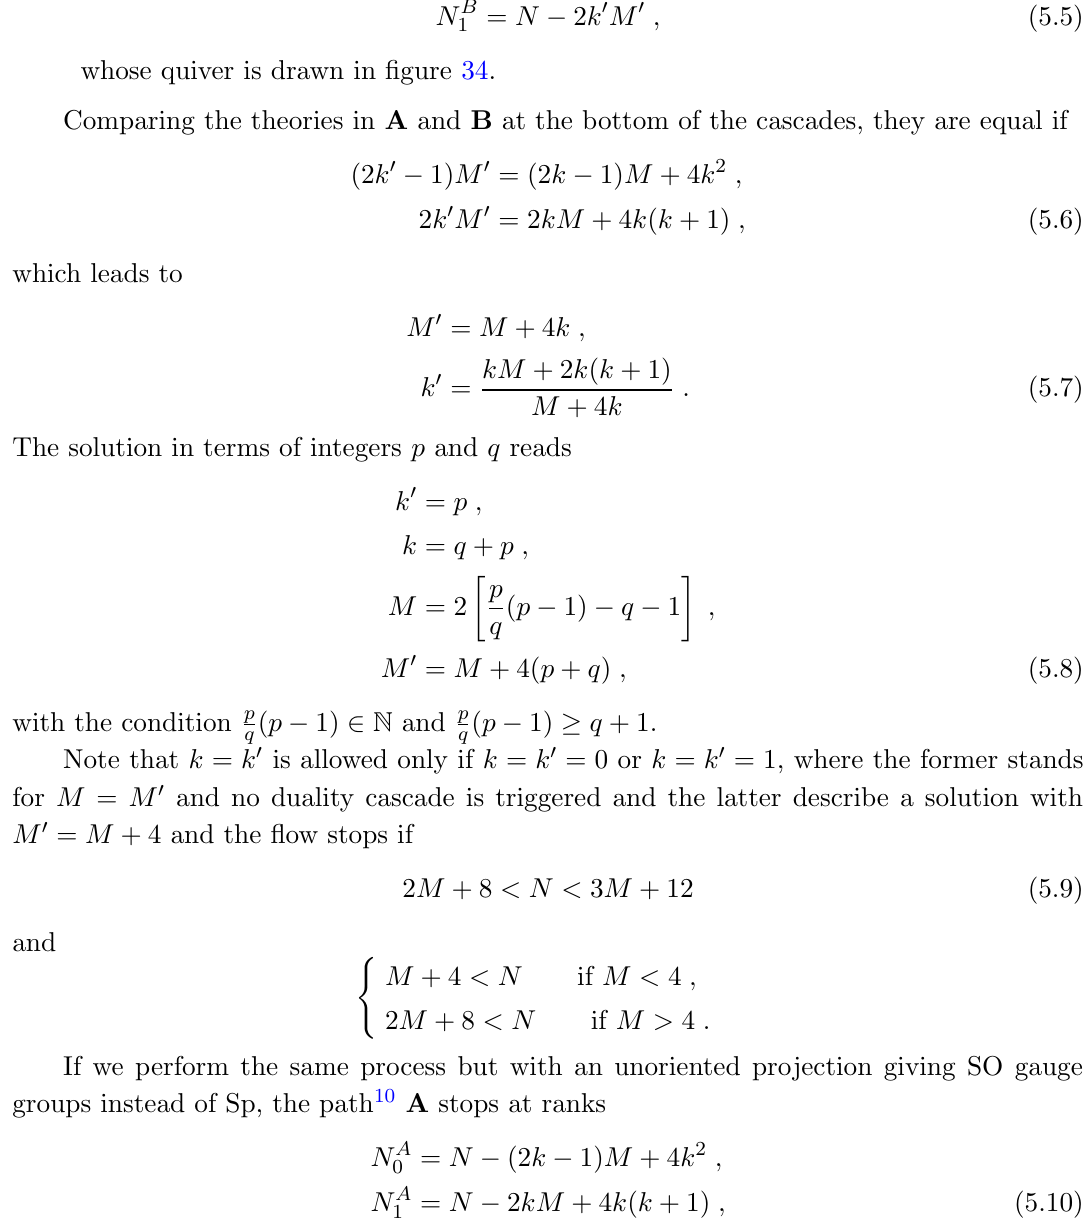
Figure 34. The unoriented theory at the end of the duality cascade of C = Z 0 projection is performed after the